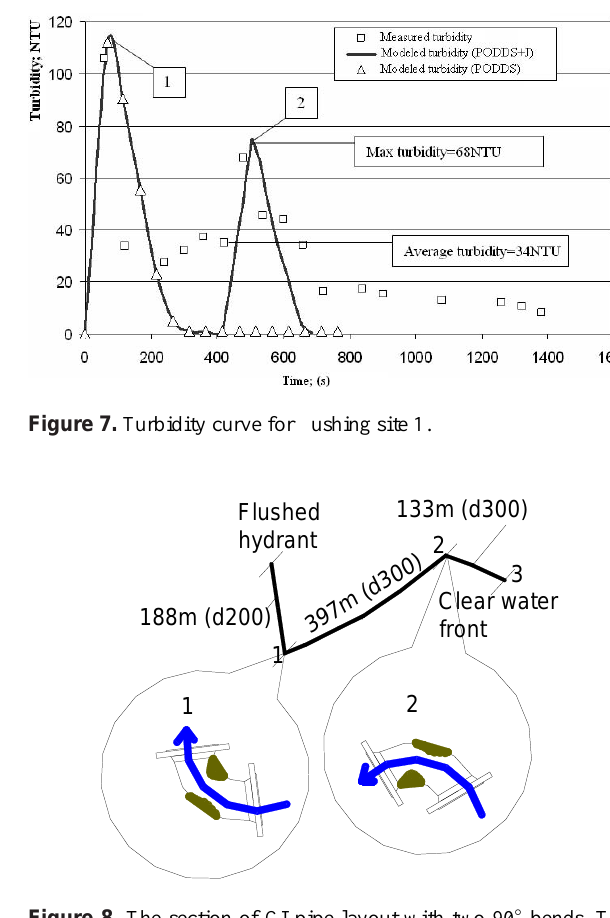
Figure 8. The section of CI pipe layout with two 90 ◦ bends. The diameters in mm are shown in brackets. 3